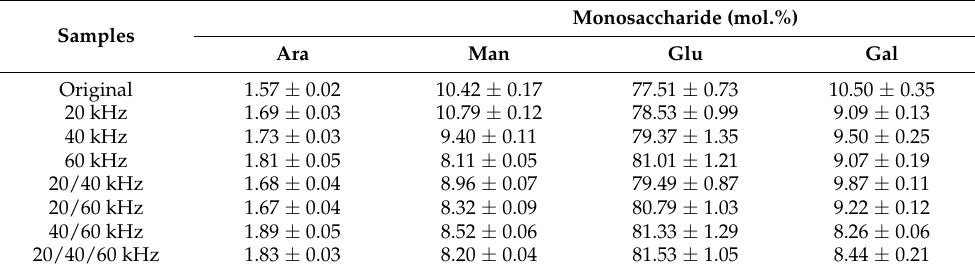
Table 1. Monosaccharide composition of lentinan under different ultrasonic frequency modes before and after ultrasonic